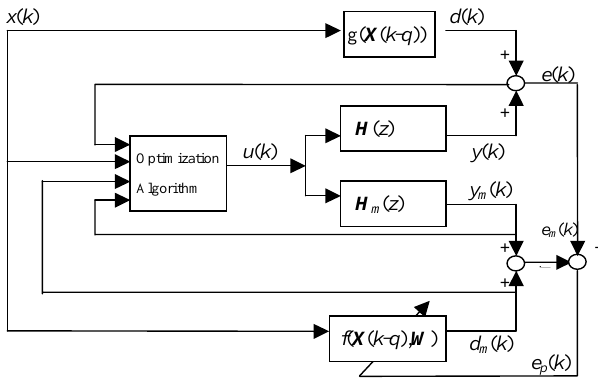
Fig. 3. Block diagram of adaptive ANC system with online primary path modeling.